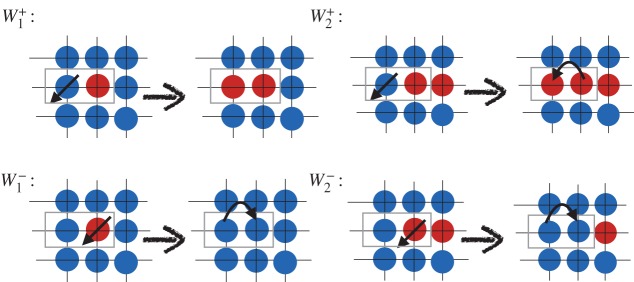
Sequence of death and birth events in the early stages of one-mutant and two-mutant clone (red=mutant). (Figure is depicted for a DB process.)